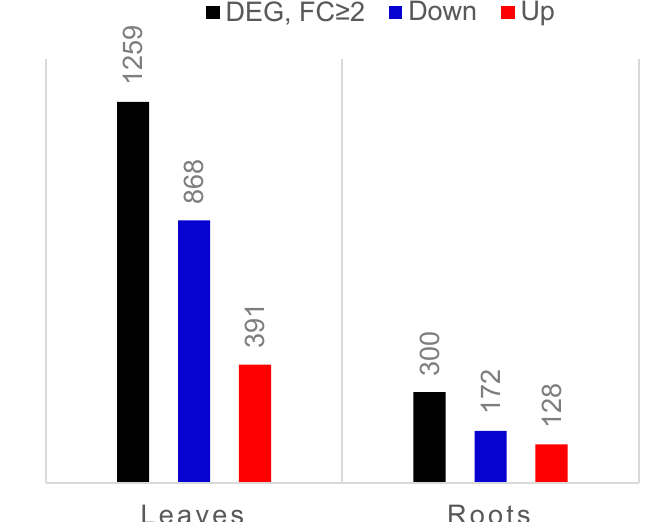
Figure 1. Bar chart showing the number of differentially expressed genes (DEGs; FDR-corrected p -value ≤ 0.05) in leaves and roots of endophyte-colonised compared to endophyte-free tomato plants. The black bars represent the total number of DEGs that exhibited at least two-fold changed expression (FC ≥ 2). Upregulated genes are marked in red and downregulated genes are marked in blue.